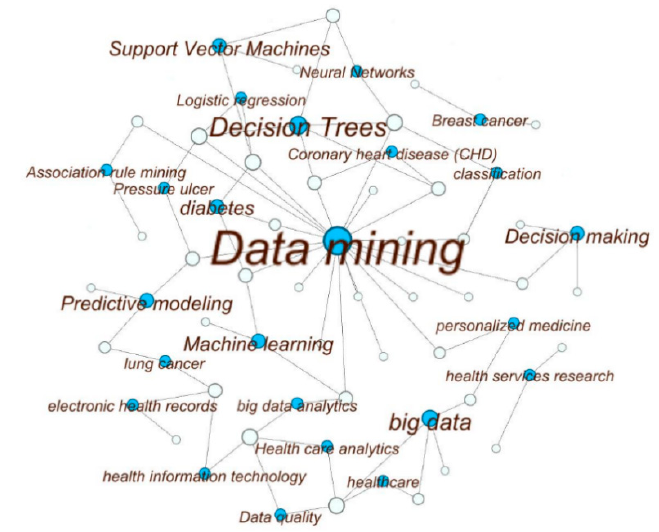
Figure 4. Visualization of high-frequency keywords of the reviewed papers. The white circles symbolize the articles and the blue circles represent keywords. The keywords that occurred only once are eliminated as well as the corresponding articles. The size of the blue circles and the texts represent how often that keyword is found. The size of the white circles is proportional to the number of keywords used in that article. The links represents the connections between the keywords and the articles. For example, if a blue circle has three links (e.g., Decision-Making) that means that keyword was used in three articles. The diagram is created with the open source software Gephi [34].